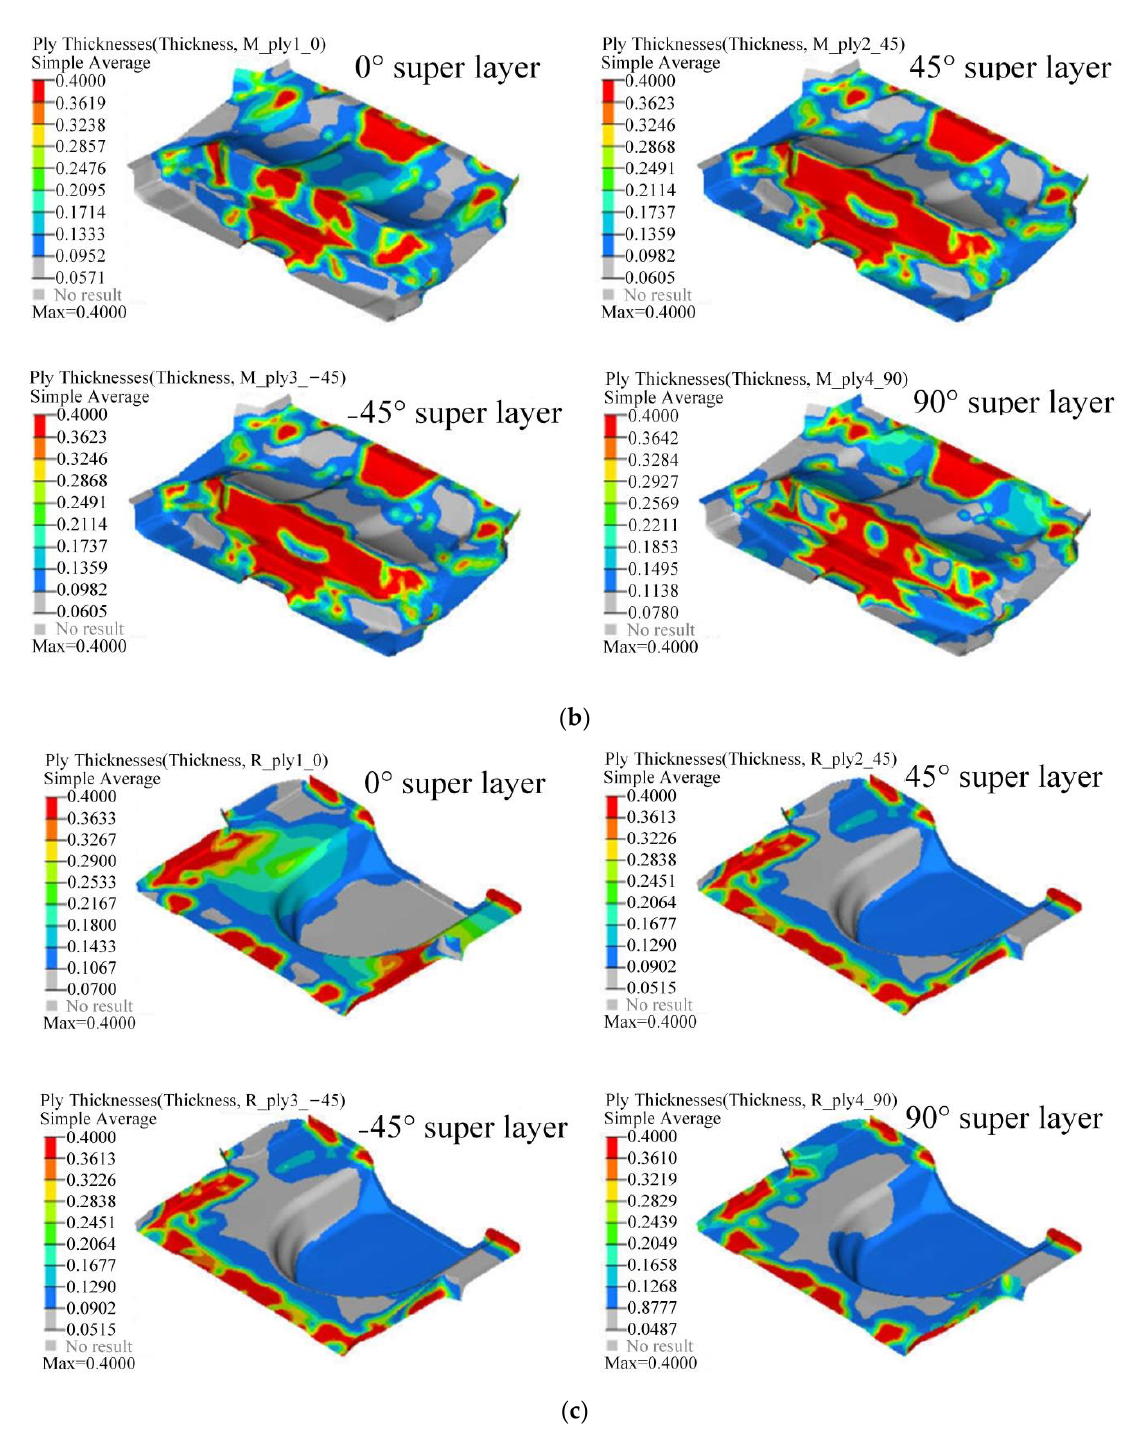
Figure 18. Optimal thickness distribution of super layer: ( a ) Front floor; ( b ) Middle floor; ( c ) Rear floor.